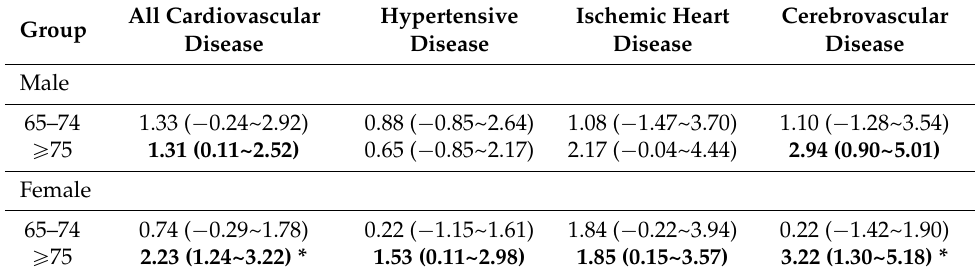
Table 4. Percent change (mean and 95% CI) of the elderly ER admissions associated with a 1 ˝ C variation in DTR by age group among males and females in Beijing during 2009–2011 a,b